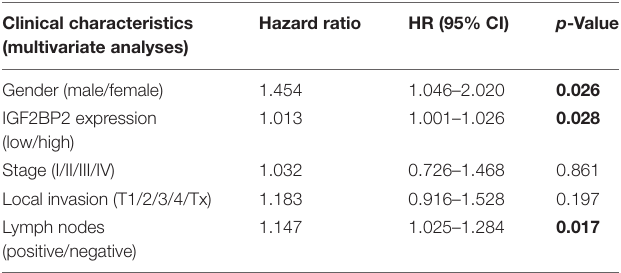
TABLE 4 | Multivariate analyses of overall survival and clinicopathologic characteristics in TCGA HNSCCs patients. Clinical characteristics (multivariate analyses)